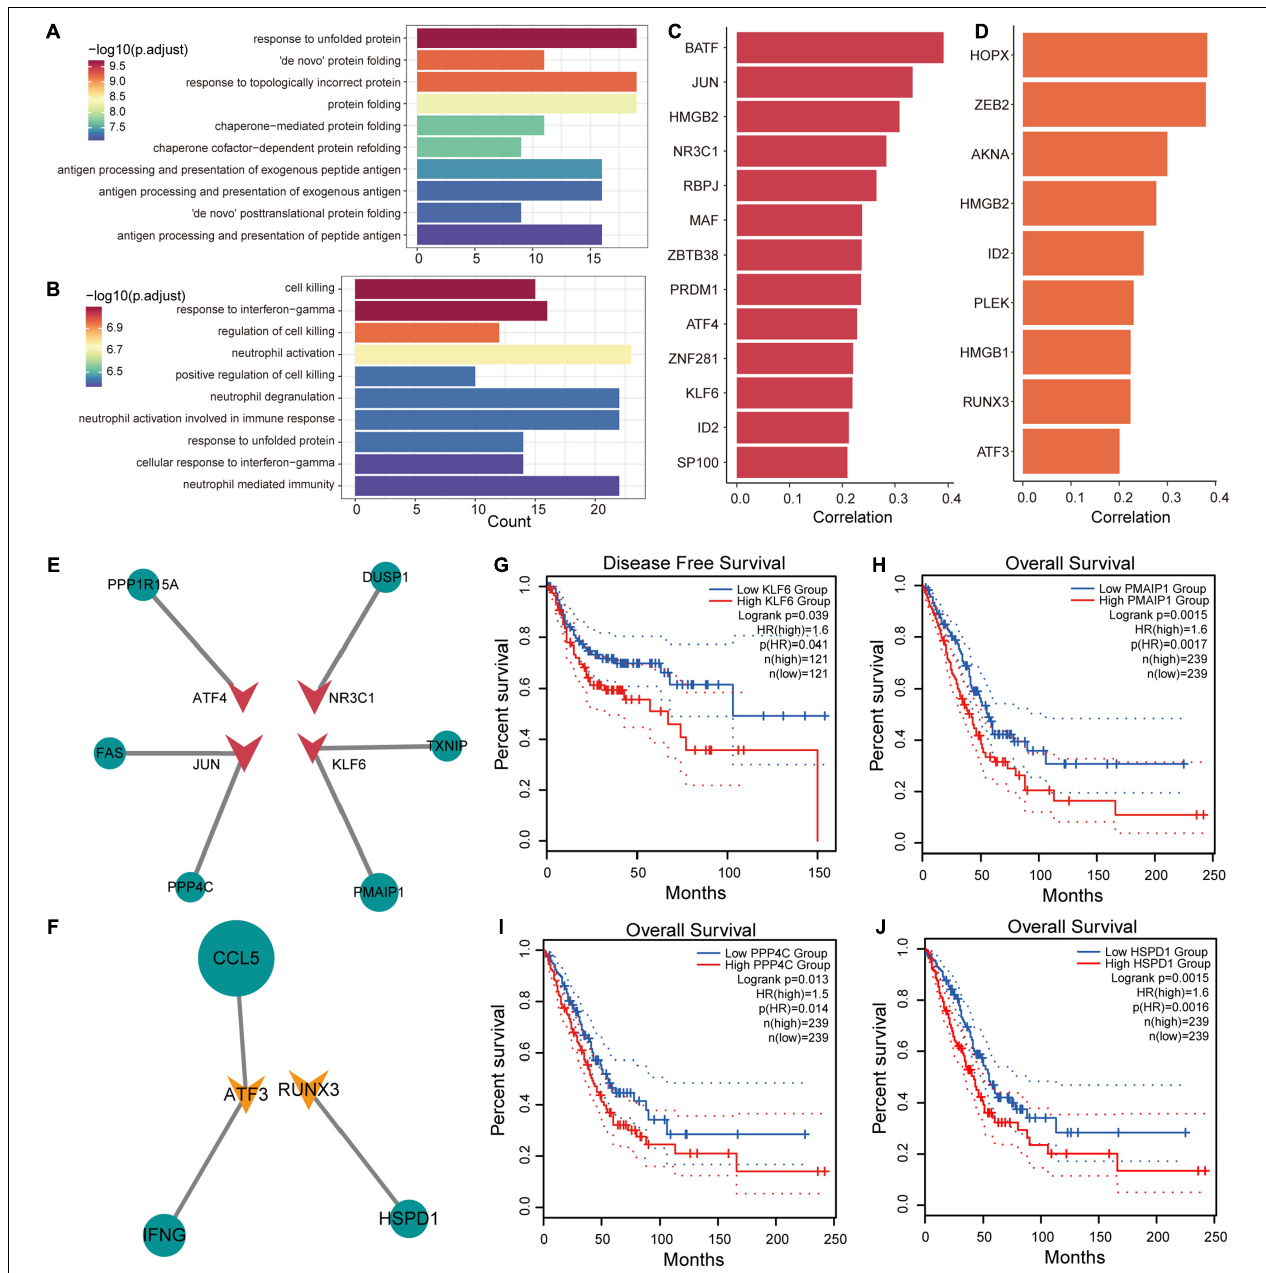
FIGURE 4 | Transcriptional regulation of genes associated with T-cell differentiation. (A) Enrichment results of upregulated genes associated with T/CD4+ differentiation in the gene ontology (GO) term. (B) Same as in (A) but for genes associated with T/CD8+ differentiation. (C) Transcription factor (TF) lists selected from genes positively associated with T/CD4+ differentiation and their Pearson correlation coefficients with pseudo-time. (D) Same as in (C) but for TF lists selected from genes associated with T/CD8+ differentiation. (E) The transcriptional regulatory network of TFs and target genes in genes related to T/CD4+ differentiation. The size of the nodes in the network represents the correlation coefficient, the circle represents the target gene, and the triangle represents the TF. (F) Same as in (E) but for genes related to T/CD8+ differentiation. (G) Survival curves comparing disease-free survival (DFS) of patients with high and low KLF6 gene expression. (H–J) Survival curves comparing overall survival (OS) of patients with high and low PMAIP1 , PPP4C , and HSPD1 gene